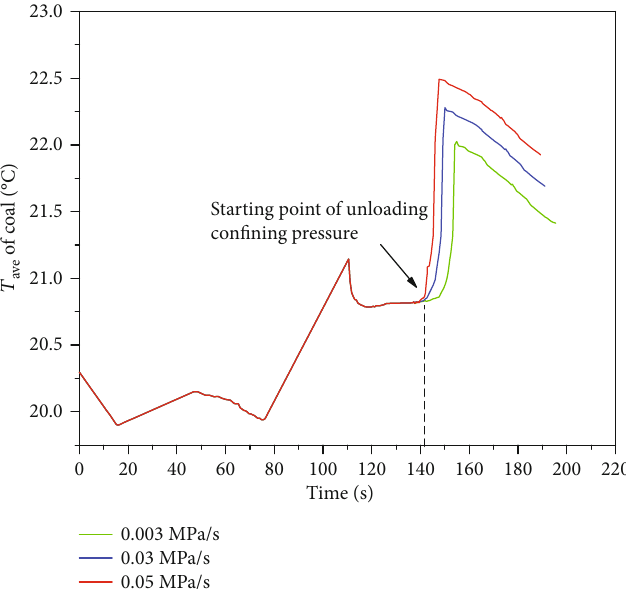
t curves of thermal infrared radiation at di ff erent con fi ning pressure unloading rates. Under the con fi ning pressure of 10MPa Figure 4: T ave - and the unloading rates of 0.003MPa/s, 0.03 MPa/s, and 0.05MPa/s, the temperature changes during the triaxial loading-unloading process of composite coal were compared, and the con fi ning pressure unloading time was